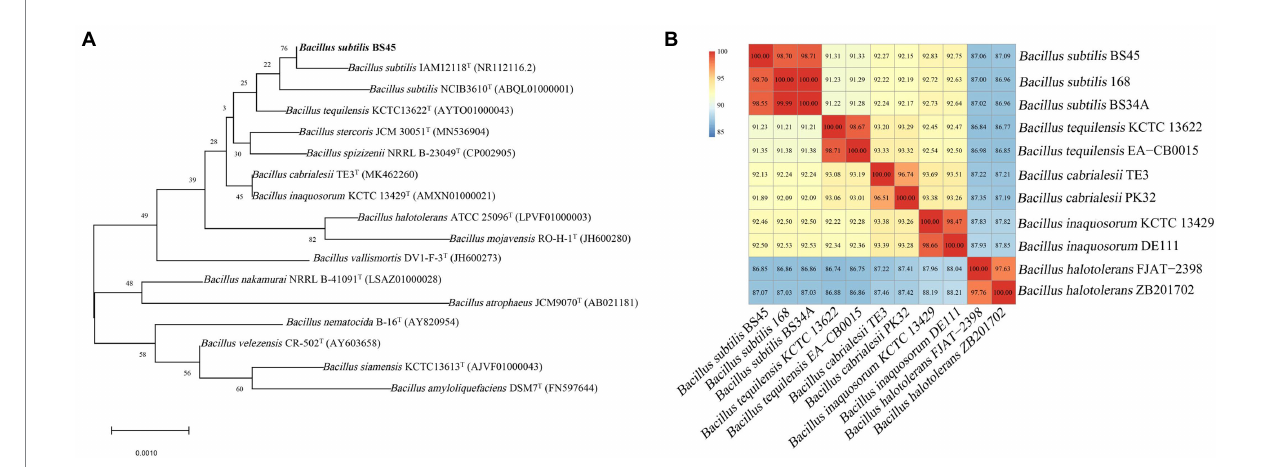
FIGURE 1 Neighbor-joining phylogenetic tree based on 16S rRNA gene sequences, showing the phylogenetic relationships of strain BS45 and related strains (A) . Heat map of the average nucleotide identity based on the complete genome sequence of strain 45 and related strains (B) .